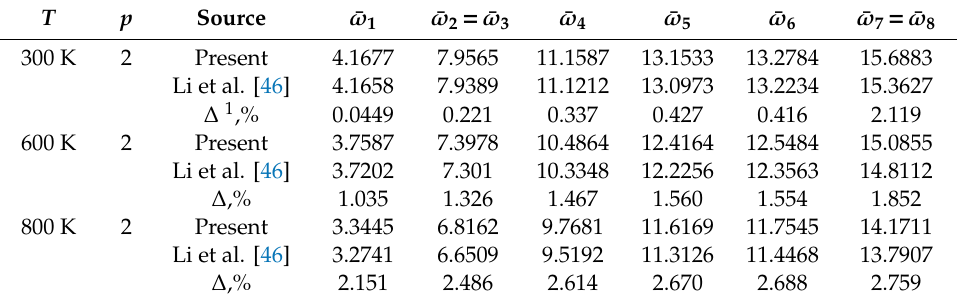
Table 2. Comparisons of nondimensional frequencies for a fully clamped (CCCC) SUS304 / Si 3 Ni 4 functionally graded square plates thermally loaded by the uniform temperature rise, T